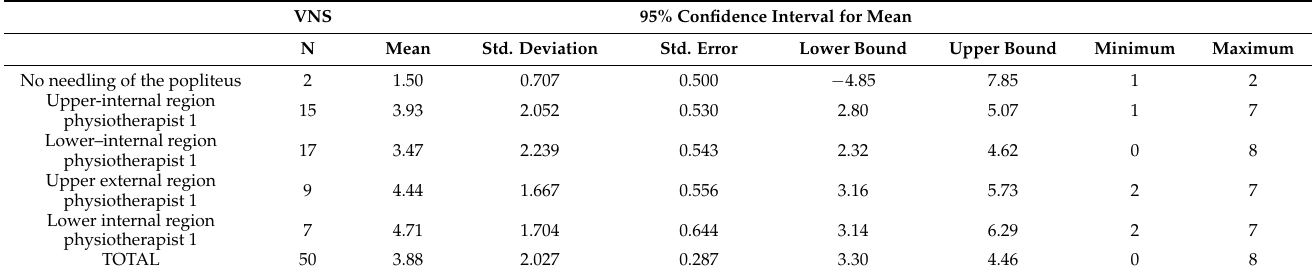
Table 5. Correlation data between the pain and muscle region for physiotherapist 1.